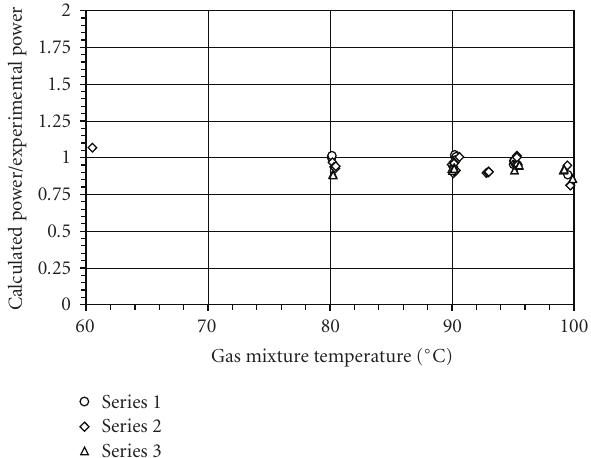
Figure 9: Results obtained for condensation on compact-finned tube heat exchangers making use of the Nir model [34]. (iii) The tertiary loop, interfaced with the secondary one through a mixing vessel, accomplishes with the function to remove heat from the test section, by extracting a prescribed flow of warm water from the vessel and replacing it with a same flow of colder water from a large